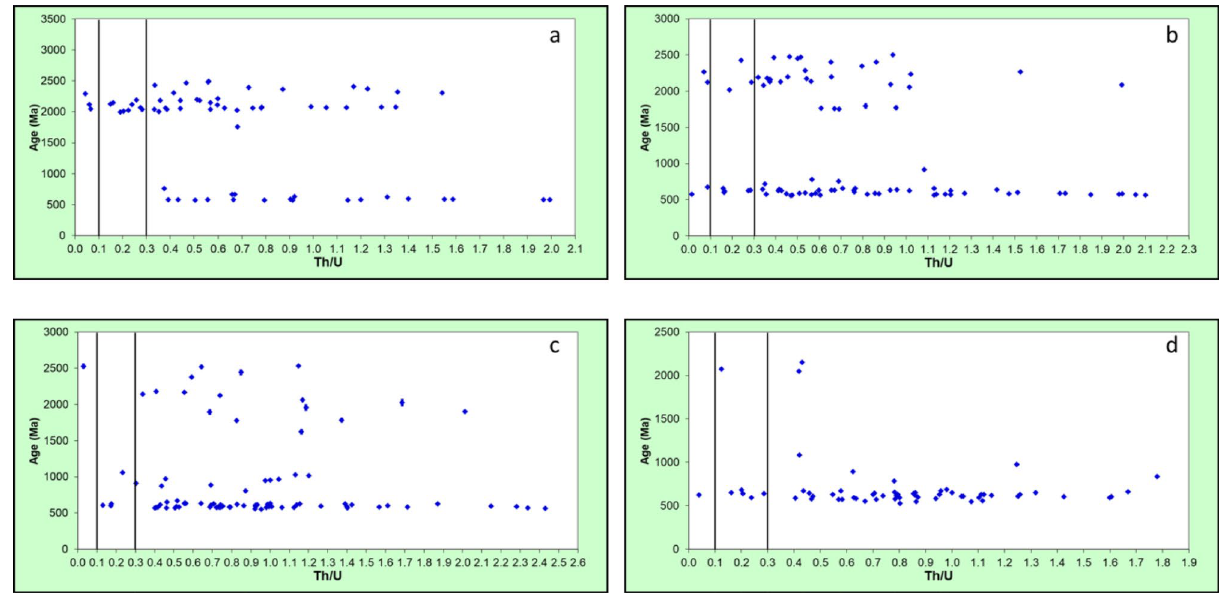
Figure 5. Th/U variation with age (Ma) in the studied ( a ) Lakiri; ( b ) Eruku; ( c ) Awo-Omama; and ( d ) Ubulu- Uku kaolins. The 0.1 and 0.3 black lines mark the upper and lower limits of zircon of metamorphic or magmatic origin, respectively 35 .